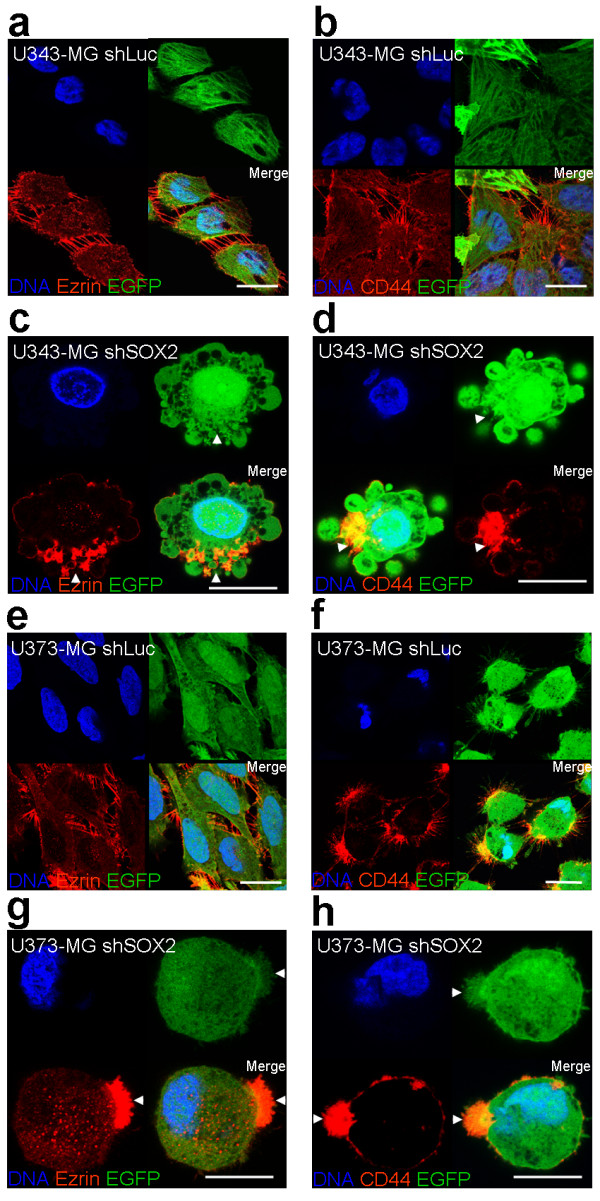
U343-MG and U373-MG cells with knockdown of SOX2 develop a single membrane protrusion containing ezrin and CD44. U343-MG and U343-MG glioma cells were transduced with retroviral vectors encoding EGFP and the indicated shRNA. Five days after transduction cells were fixed and stained with primary ezrin, CD44 antibodies and secondary Cy3-coupled antibodies as depicted in the images. DNA counterstaining was performed using Hoechst 33342. a, b: U343-MG cells transduced with shLuc control vector. c, d: U343-MG cells transduced with shSOX2 #sh2378. e, f: U373-MG cells transduced with shLuc control vector. g, h: U373-MG cells transduced with shSOX2 #sh2378. Note in c: and g: the development of a single cell protrusion containing ezrin and as shown in d and h the appearance of CD44 in single protrusions in cells with knockdown of SOX2. Magnification bars, in a, b, e, f: 20 μm; in c, d, g, h: 10 μm.